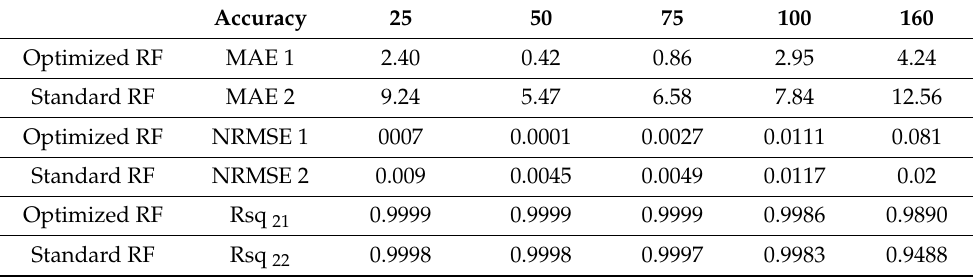
Table 5. Proposed RF-LS-BPT and standard RF regression model accuracy for testing.